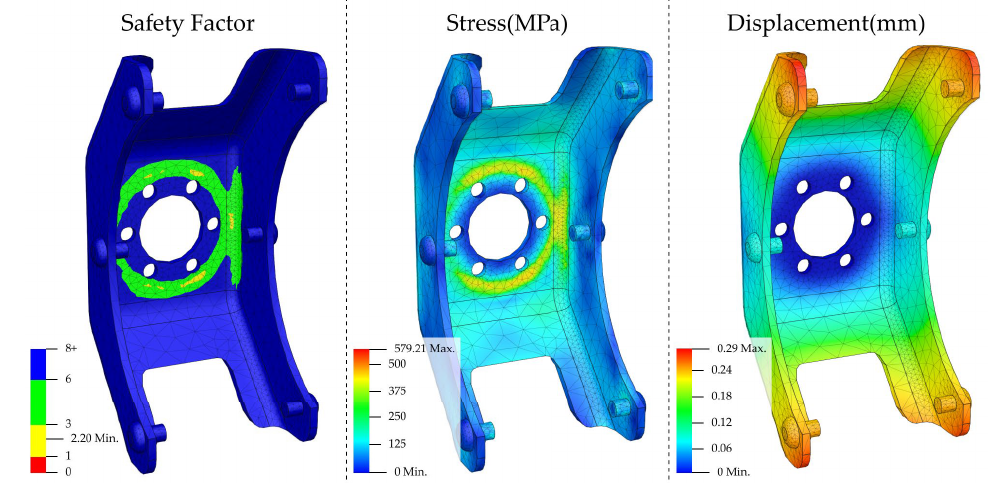
Figure 9. Analysis of condition 2 for hip connector 1. From left to right are safety factor, stress, and